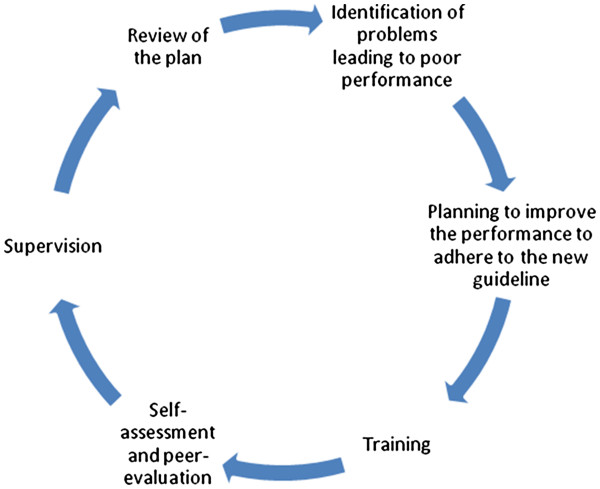
Quality improvement cycle [[17],[31]].